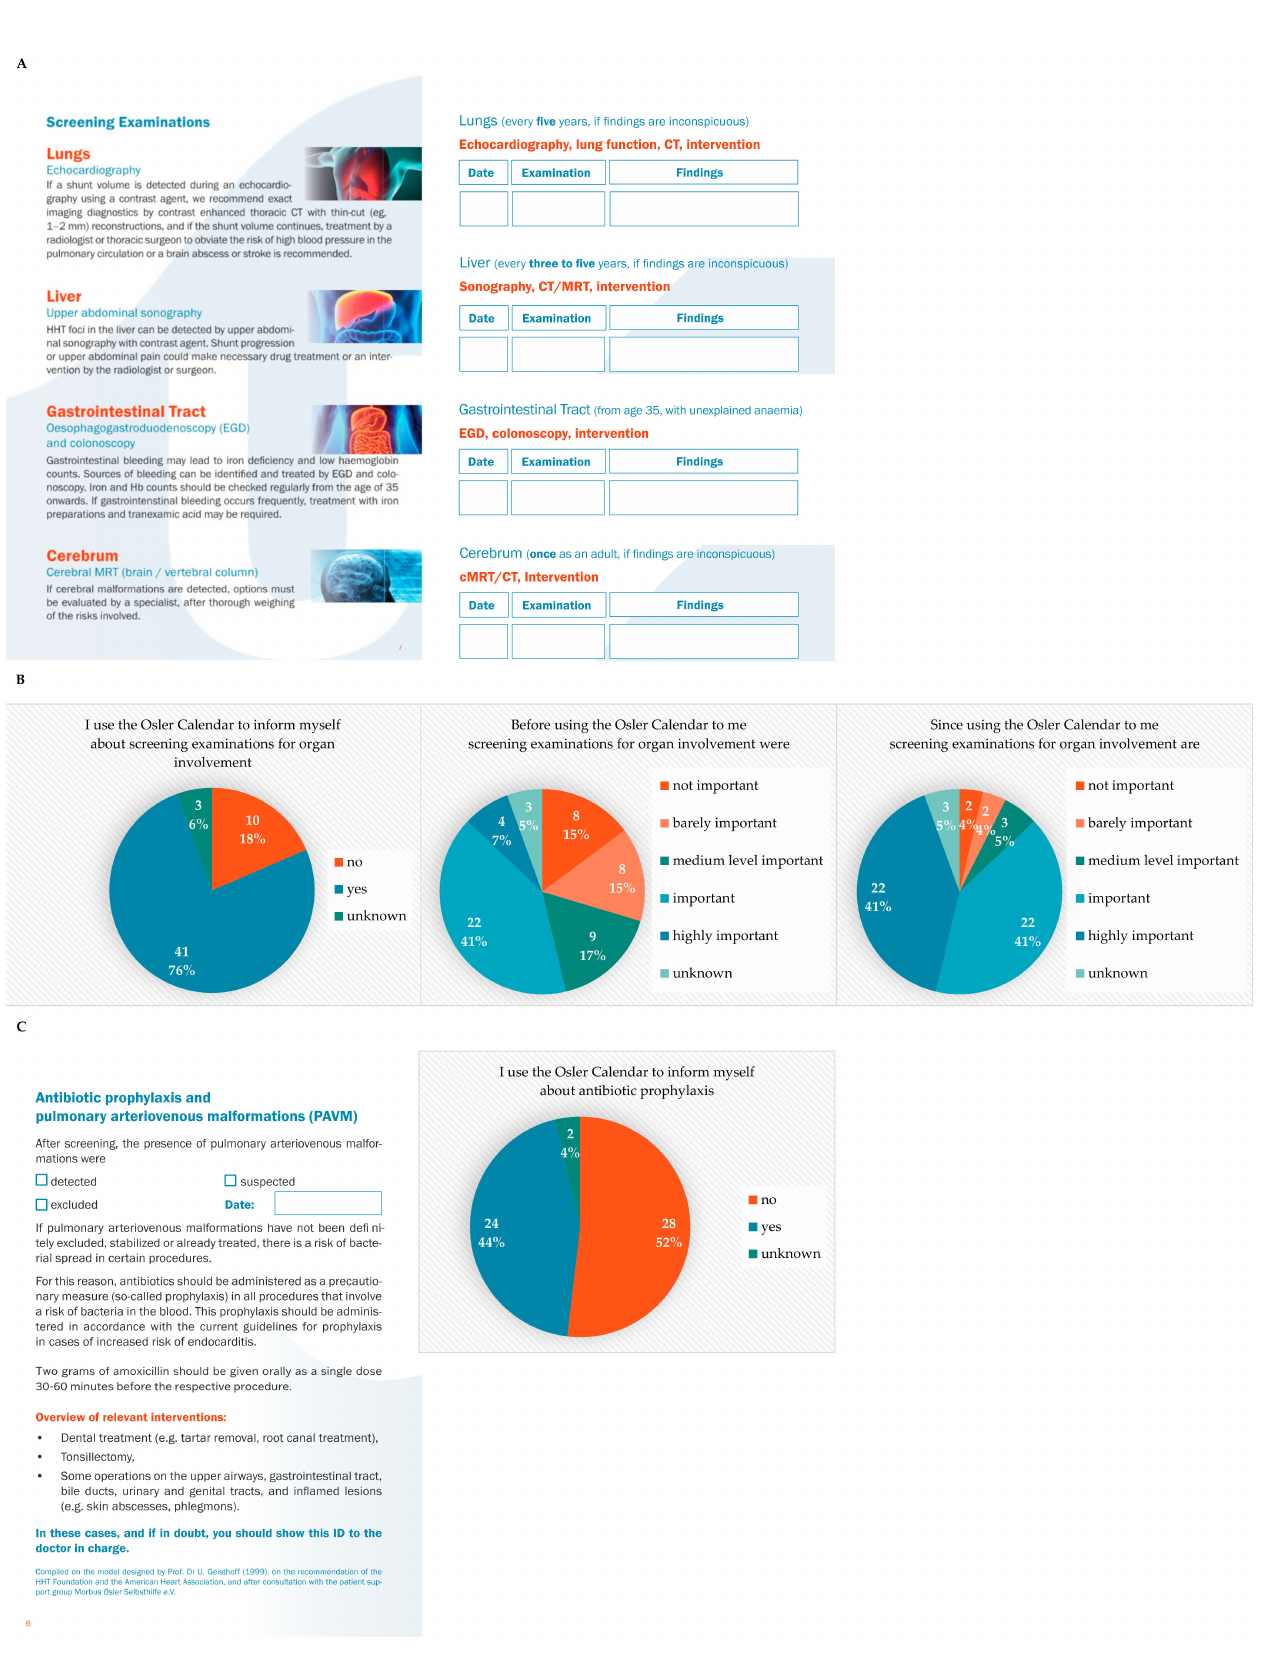
Figure 2. ( A ) Information on screening examinations for visceral lesions of HHT. ( B ) Use of the Osler Calendar for screening examinations for organ involvement. ( C ) Information on antibiotic